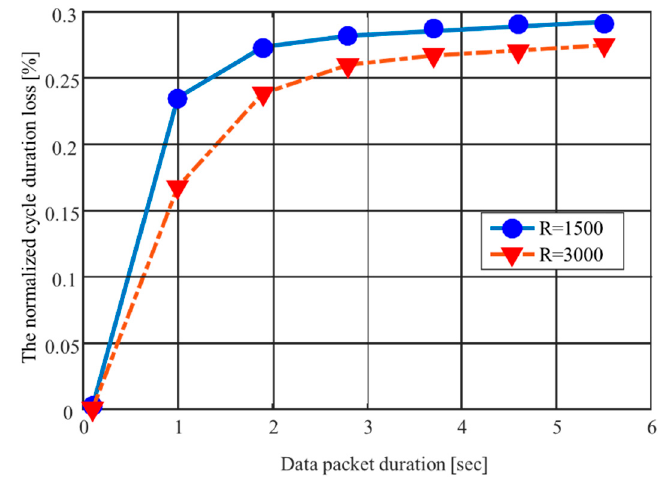
Figure 6. Performance degradation by the transmission order in which 10 nodes move at the maximum speed of 7 m/s.